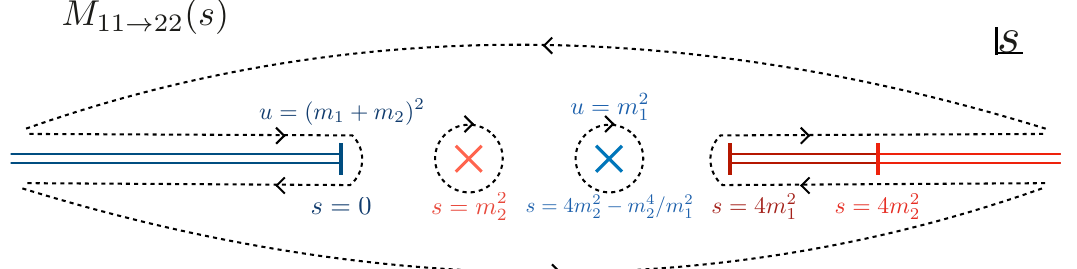
Figure 6. Analytic structure of M 11 22 ( s ). According to the kinematics in equation (2.11), as ! we move in the s plane, we hit poles and two-particle (as well as multiparticle) thresholds in the s and u channel, but not in the t -channel. This is a consequence of our arbitrary de(cid:12)nition of t and u (in the language of appendix A, this comes from choosing for each s a single point in the two-valued hyperbolas of (cid:12)gure 15). To derive the dispersion (3.4) we start by assuming the amplitude approaches a constant at in(cid:12)nity (but see discussion in the main text) and write